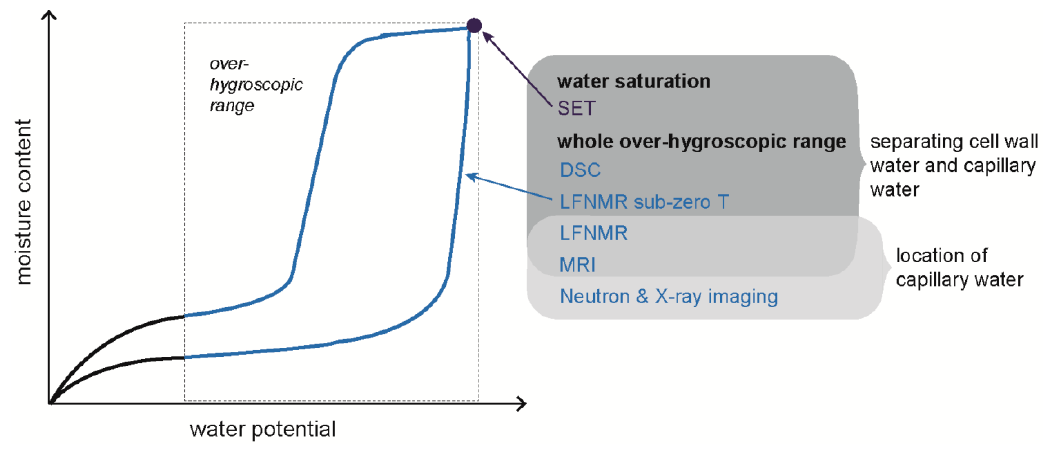
Figure 4. Overview of methods that can be used to study location of water in the over-hygroscopic moisture range.